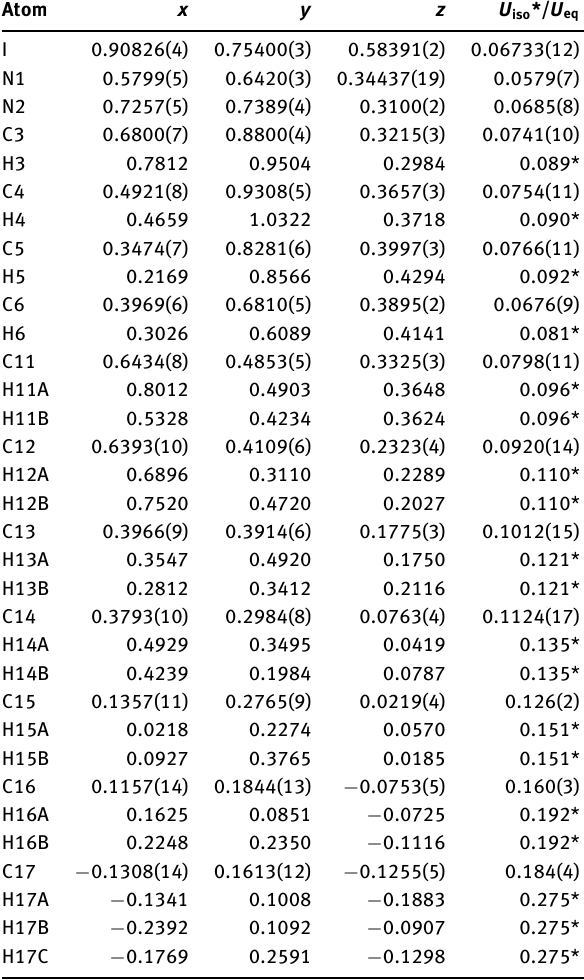
Table 2: Fractional atomic coordinates and isotropic or equivalent isotropic displacement parameters (Å 2 ).